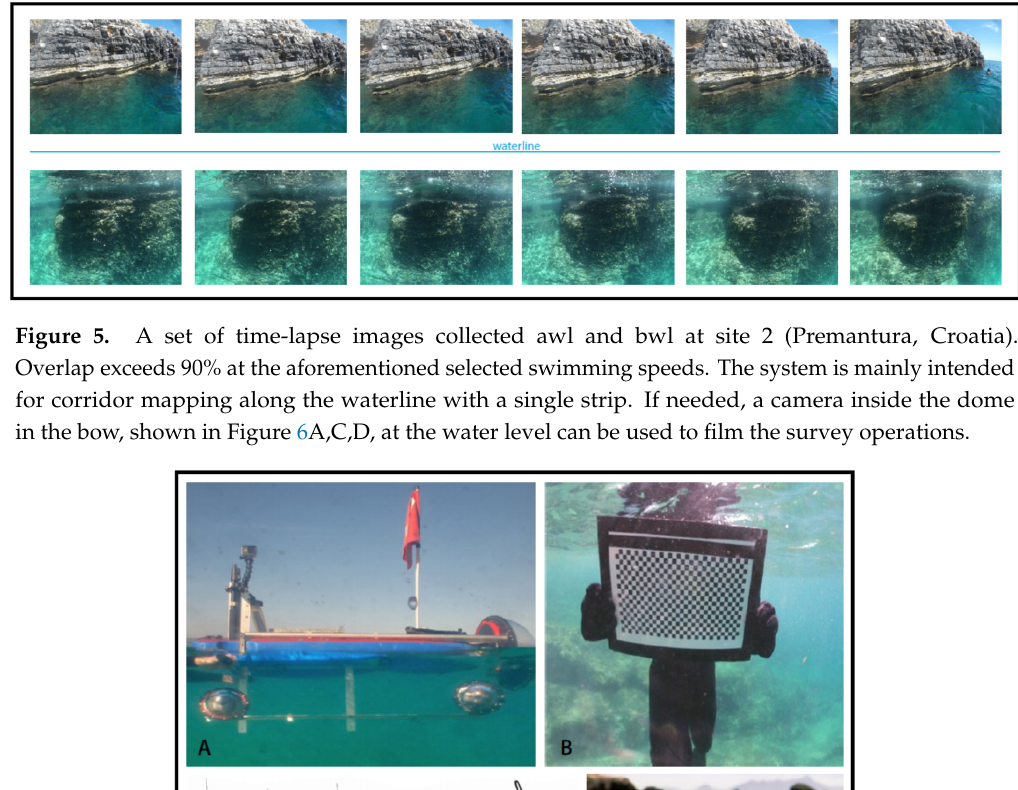
Figure 6. ( A ) The configuration of the cameras hosted on the raft used for the photogrammetric acquisition; ( B ) Underwater/subaerial photogrammetric target used to calibrate the distortion index due to surface roughness in underwater photogrammetry; ( C ) Sketch of the acquisition of time-lapse images along the coastal routes. The swimming is carried out at 1 ± 0.5 m from the shore, at a speed of about 1 to 2 km/h. The camera positioned within the dome at the front of the raft, inclined at 45° with respect to the coastline, is used to document the survey; ( D ) The cameras within the domes mounted laterally are positioned at –0.5 m below the waterline and at 1 m above.